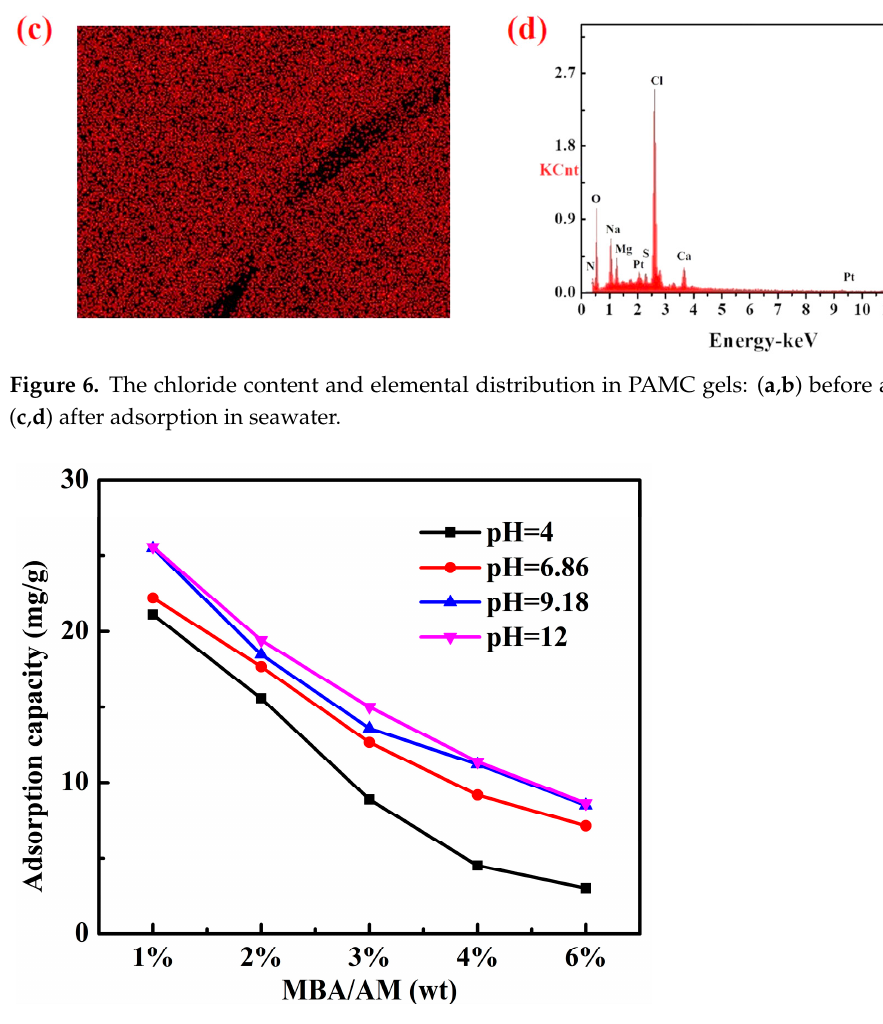
Figure 7. Effect of pH on adsorption capacity of PAMC. Table 3. Equilibrium swelling degree of PAMC-1 in NaCl solutions with different pH values.